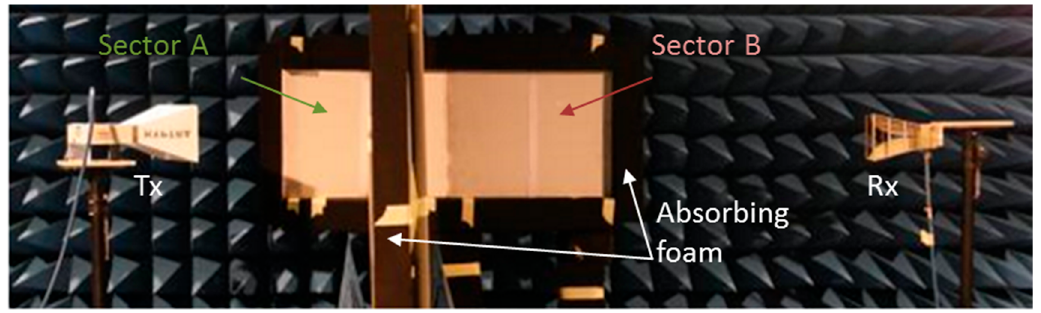
Figure 9. Picture of the measurement setup.